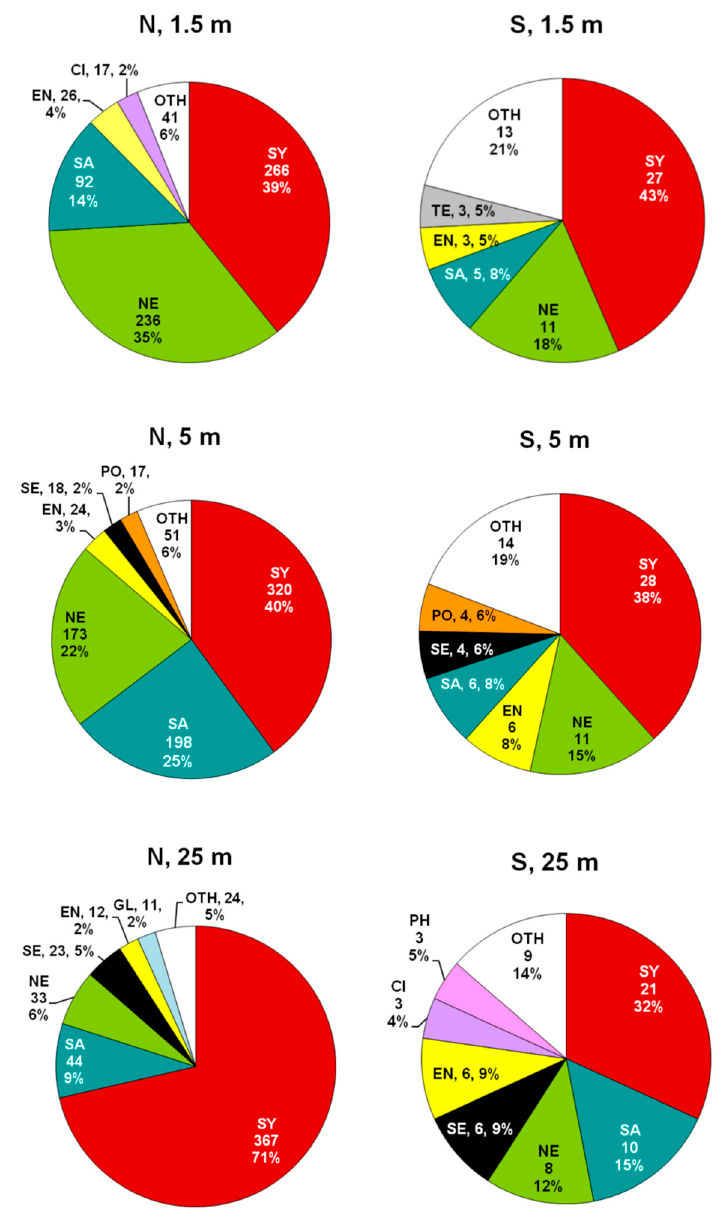
Figure 5. Cumulative abundance (N; on the left side) and species richness (S; on the right side) of polychaetes per family at the three studied depths. CI—Cirratulidae, EN—Eunicidae, GL—Glyceridae, NE—Nereididae, PH—Phyllodocidae, PO—Polynoidae, SA—Sabellidae, SE—Serpulidae, SY—Syllidae, TE—Terebellidae, OTH—other polychaetes.